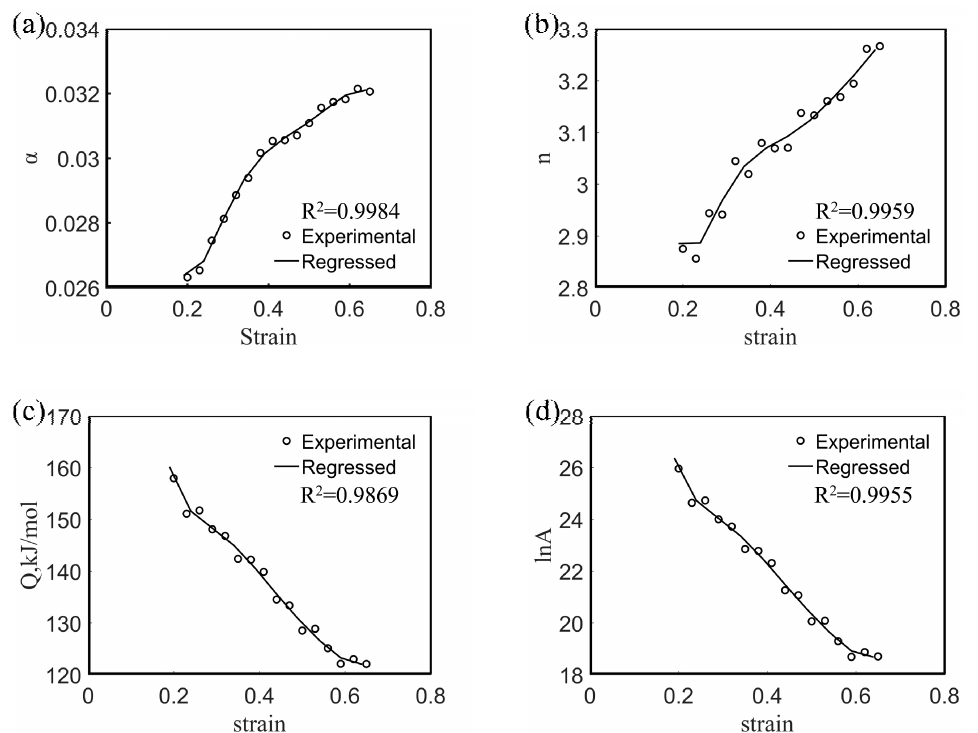
Figure 8. Variations of α ( a ), n ( b ), Q ( c ), and ln A ( d ) with true strain based on sixth-order polynomial-fit for the experimental alloy.